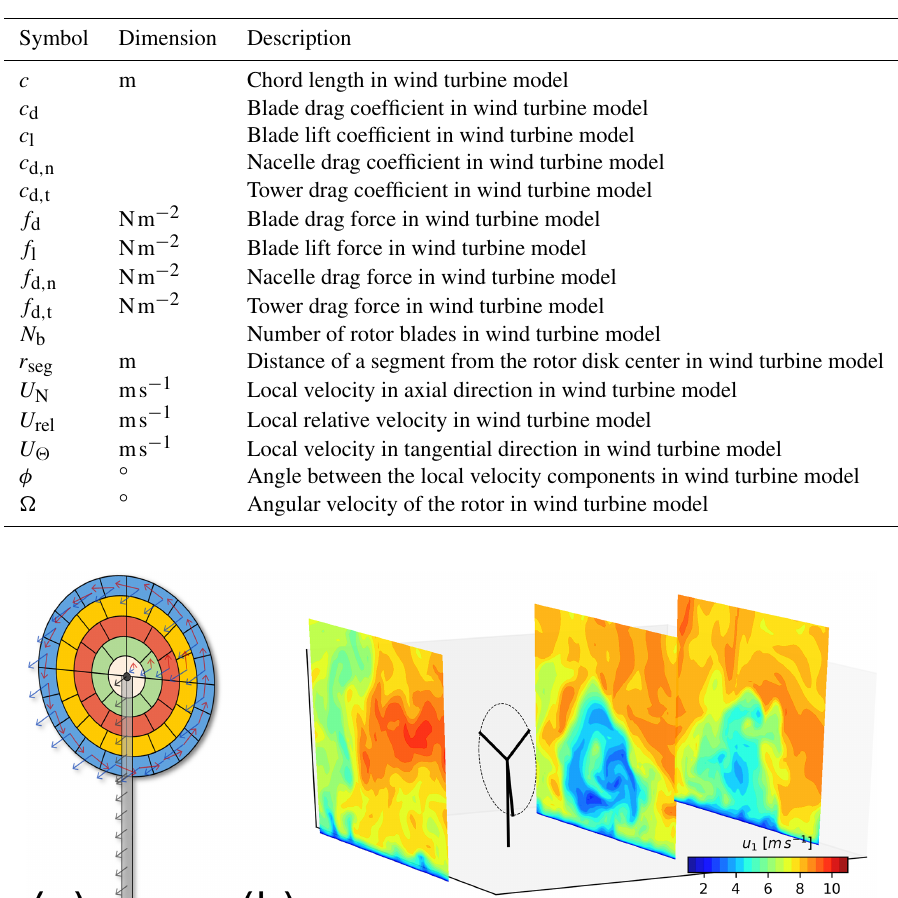
Table 8. List of symbols related to the wind turbine model.